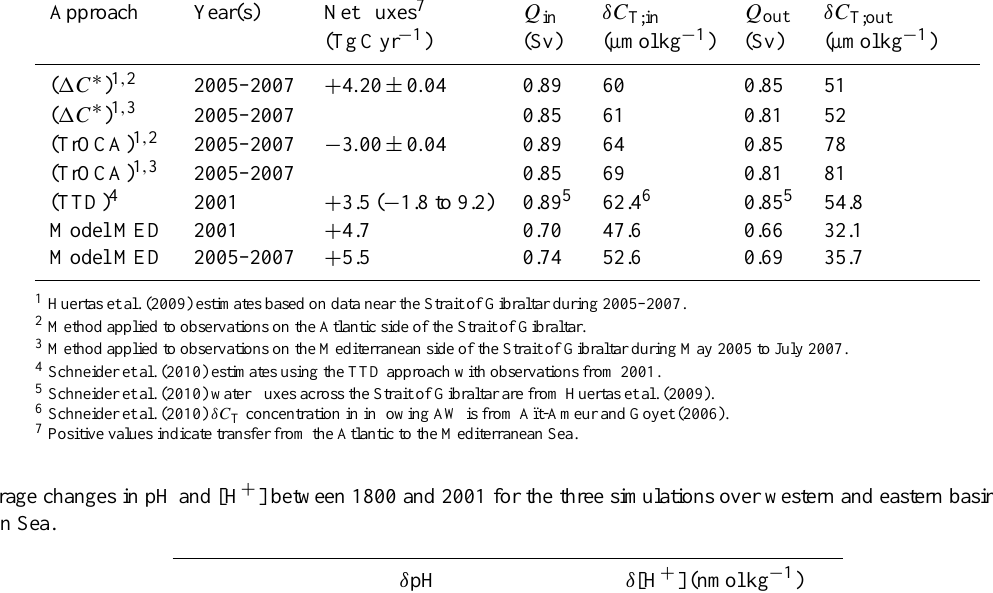
Table 6. Lateral fluxes of water and anthropogenic carbon across the Strait of Gibraltar. Approach